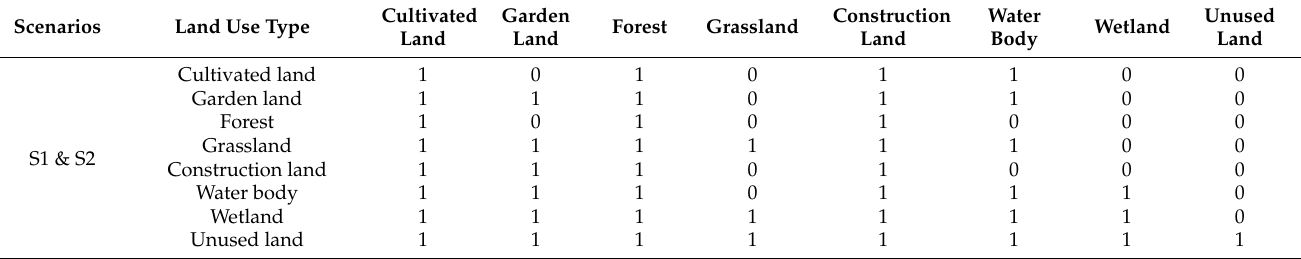
Table 5. Conversion cost